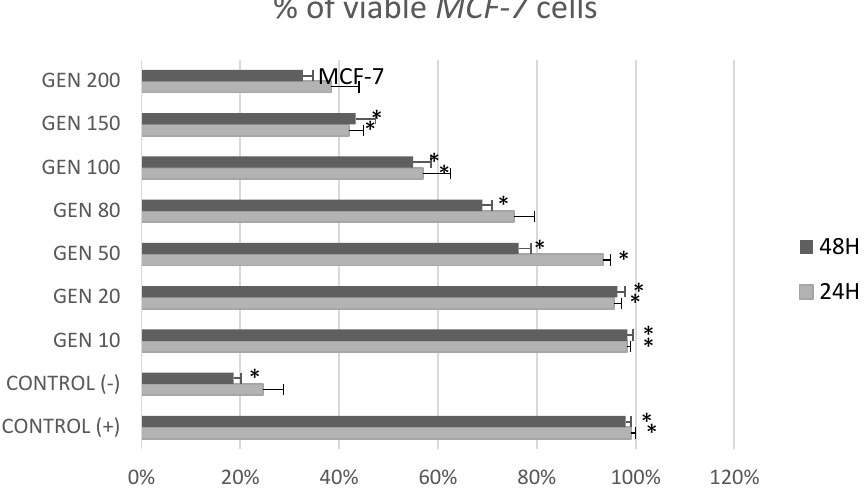
Figure 5. Percentage of viable MCF7 cells [%] in trypan blue exclusion assay after treatment with genistein at different concentration [μM]. Results are the mean ± SD of n = 3. * Statistically significant ( p < 0.05; ANOVA followed by Dunnett’s test compared with control group). Cells cultured with 0.1% DMSO were considered Control (+). Cells cultured with 15% DMSO were considered Control ( − ).